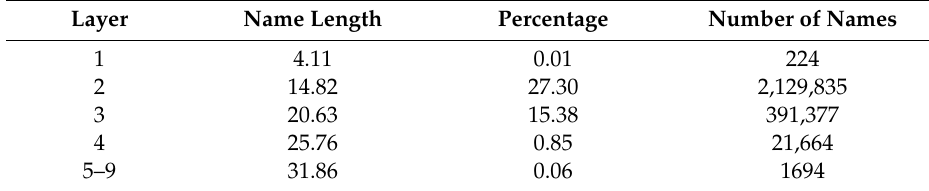
Table 3. Three-meter prefix table.